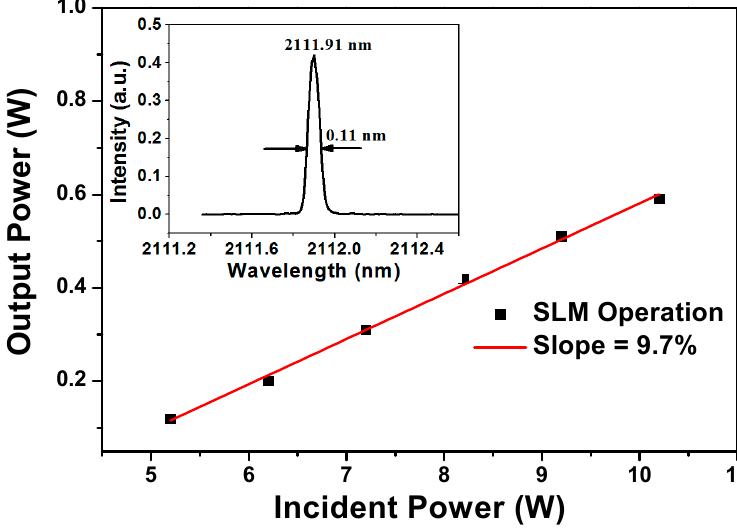
Figure 6. The performance of the SLM Ho:SSO laser.